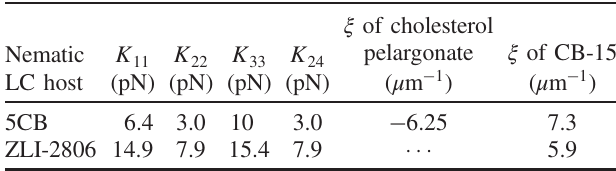
TABLE 1. Elastic constants of the nematic LC hosts and helical twisting power ξ of the used chiral additives when doped into these nematic